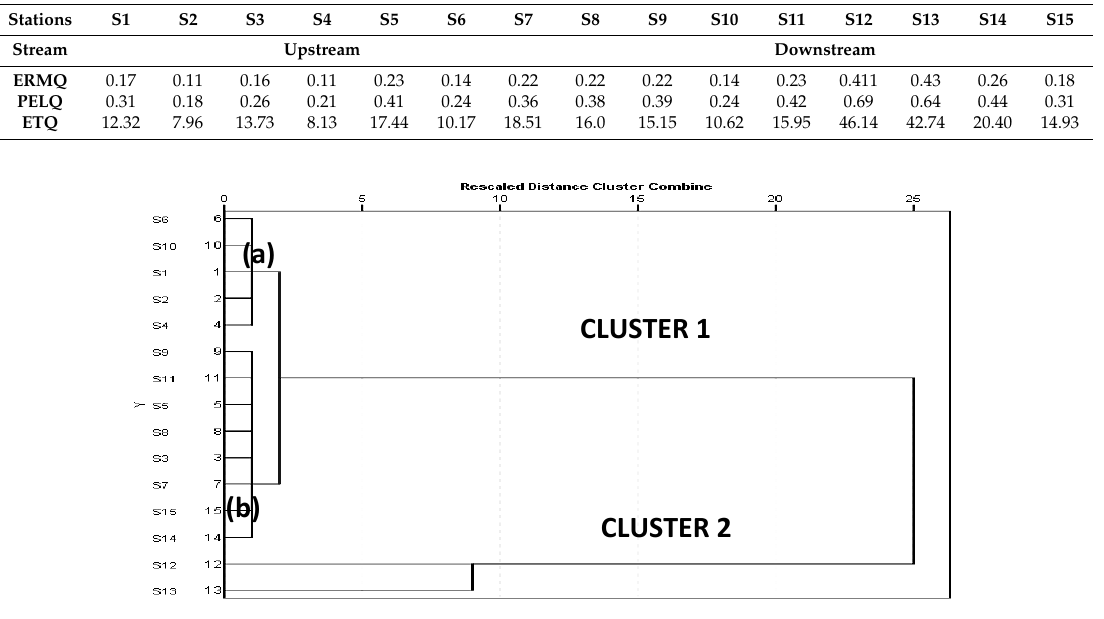
Figure 7. Cluster analysis (“a” and “b” represent sub cluster) of sampling stations in the Perak River.